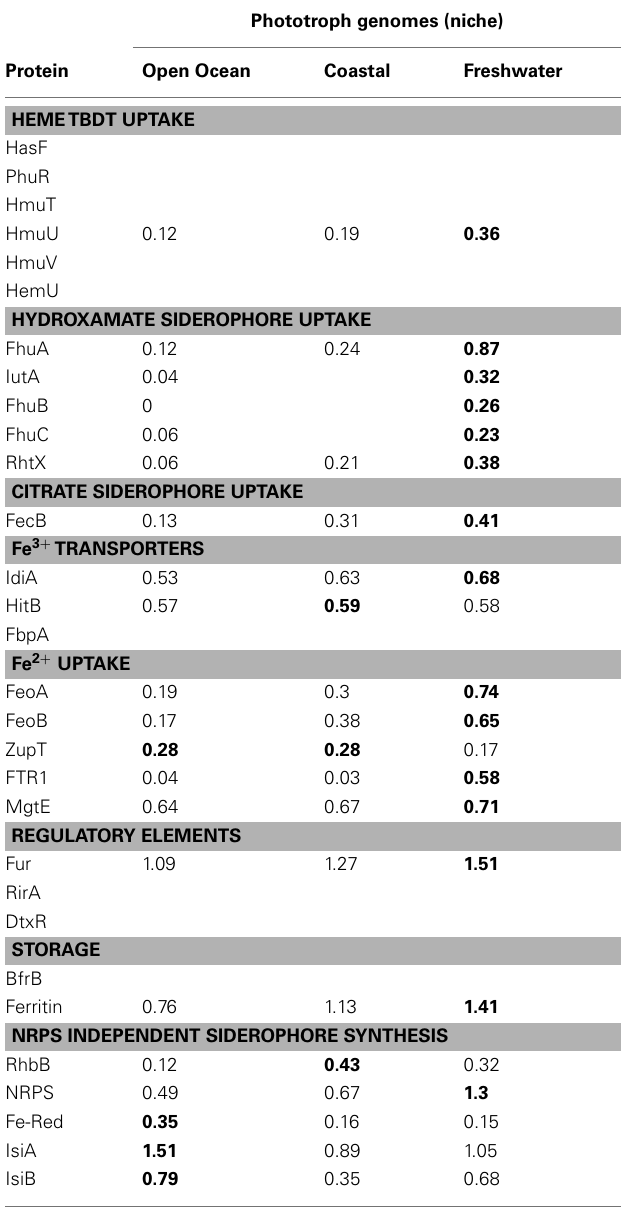
Table 4 | Proteins discriminating between aquatic niche groups in phototrophic genomes identified using the Similarity Percentages (SIMPER)